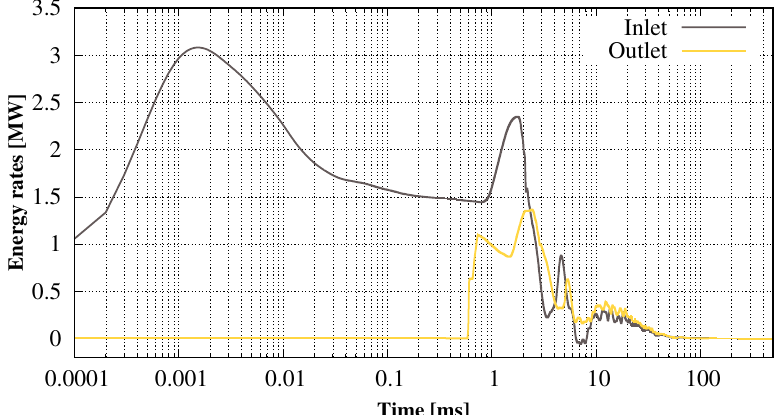
Figure 18. Inlet and outlet energy time